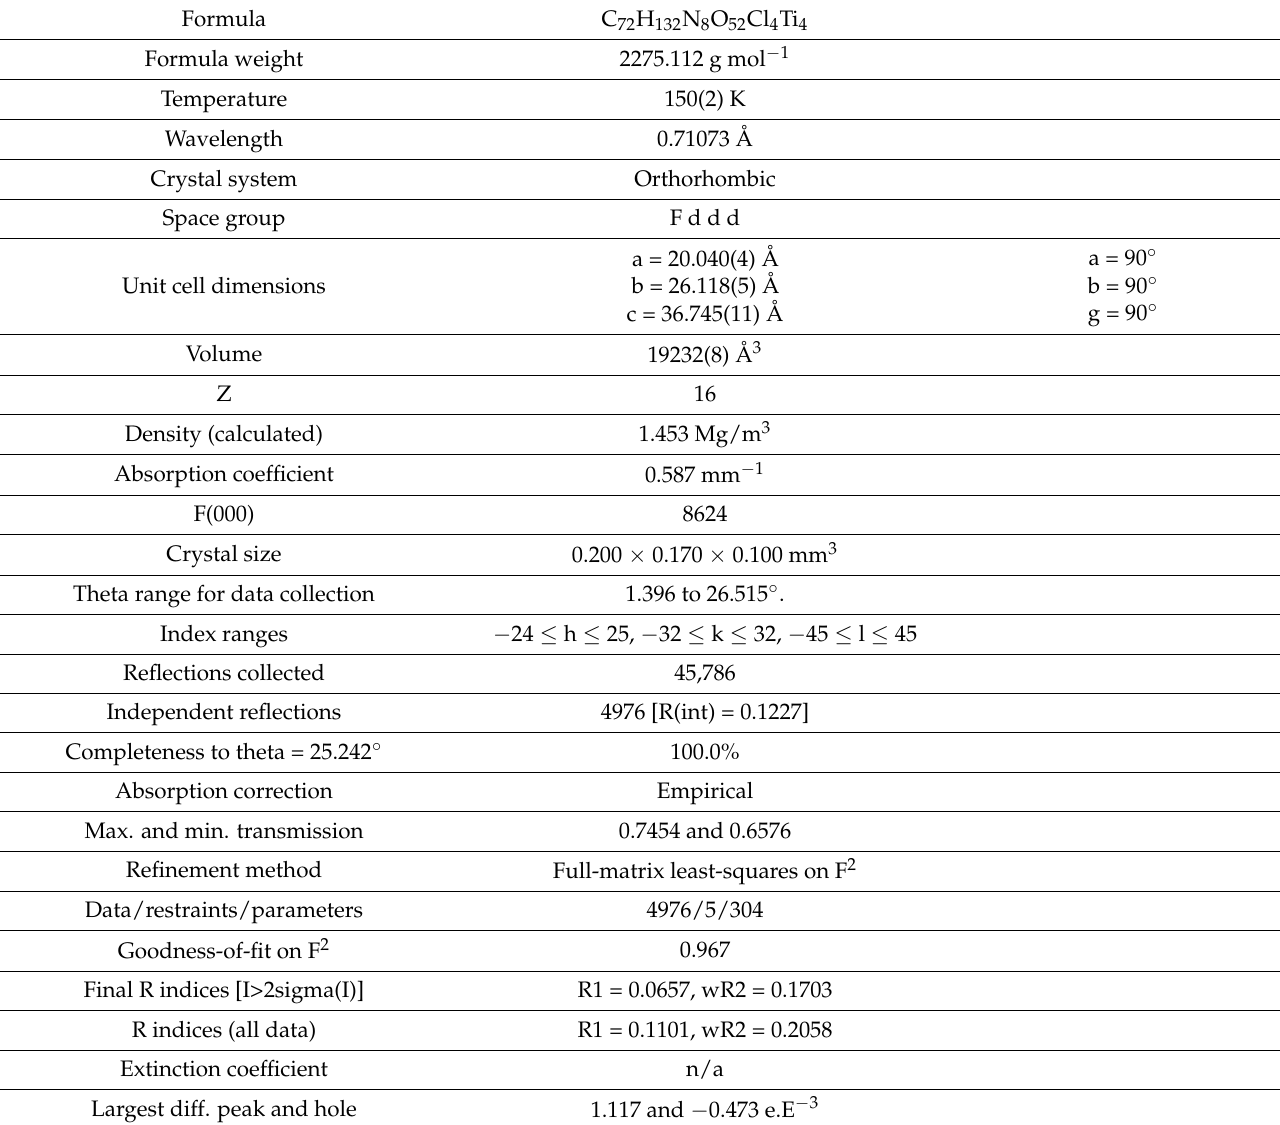
Table 4. Crystal data and details of the structure determination and refinement for the tetranuclear titanium cluster 1 .